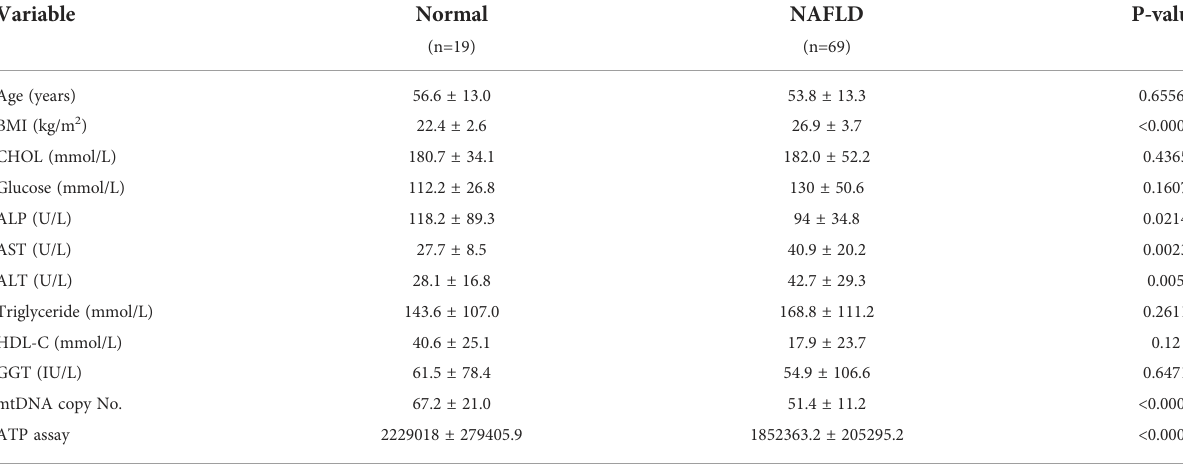
TABLE 2 Clinical characteristics of the patients (mtDNA copy number and ATP). Variable